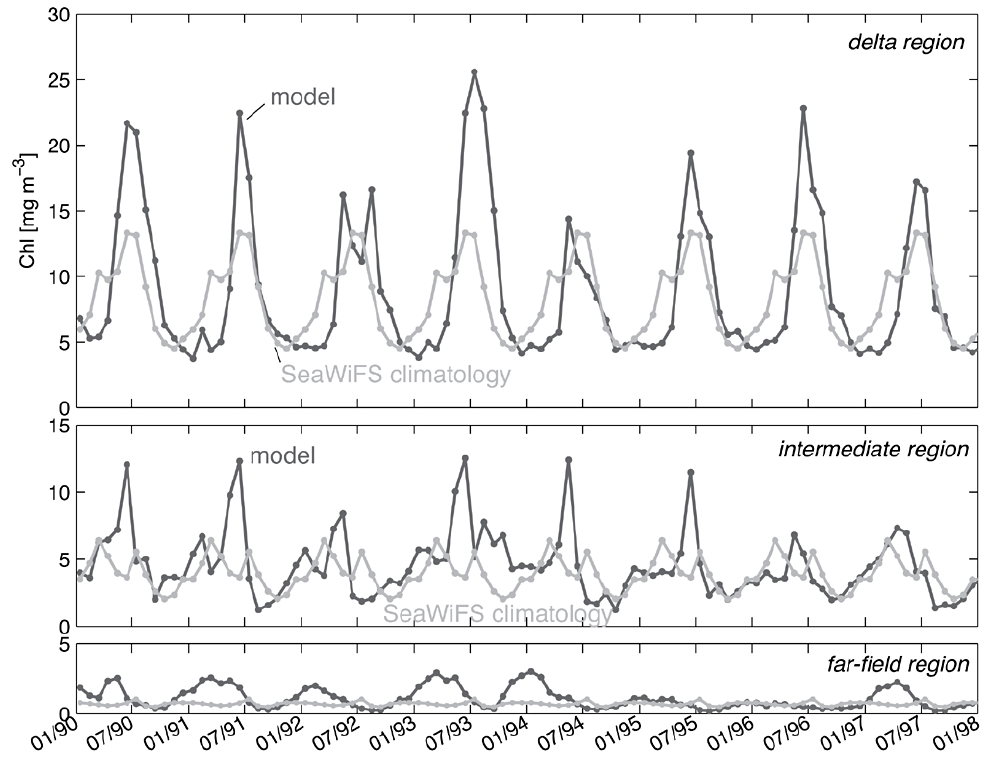
Fig. 7. Monthly mean surface chlorophyll concentrations for January 1990 to December 1997 in comparison with the monthly SeaWiFS climatology, both averaged over the delta, intermediate and far-field